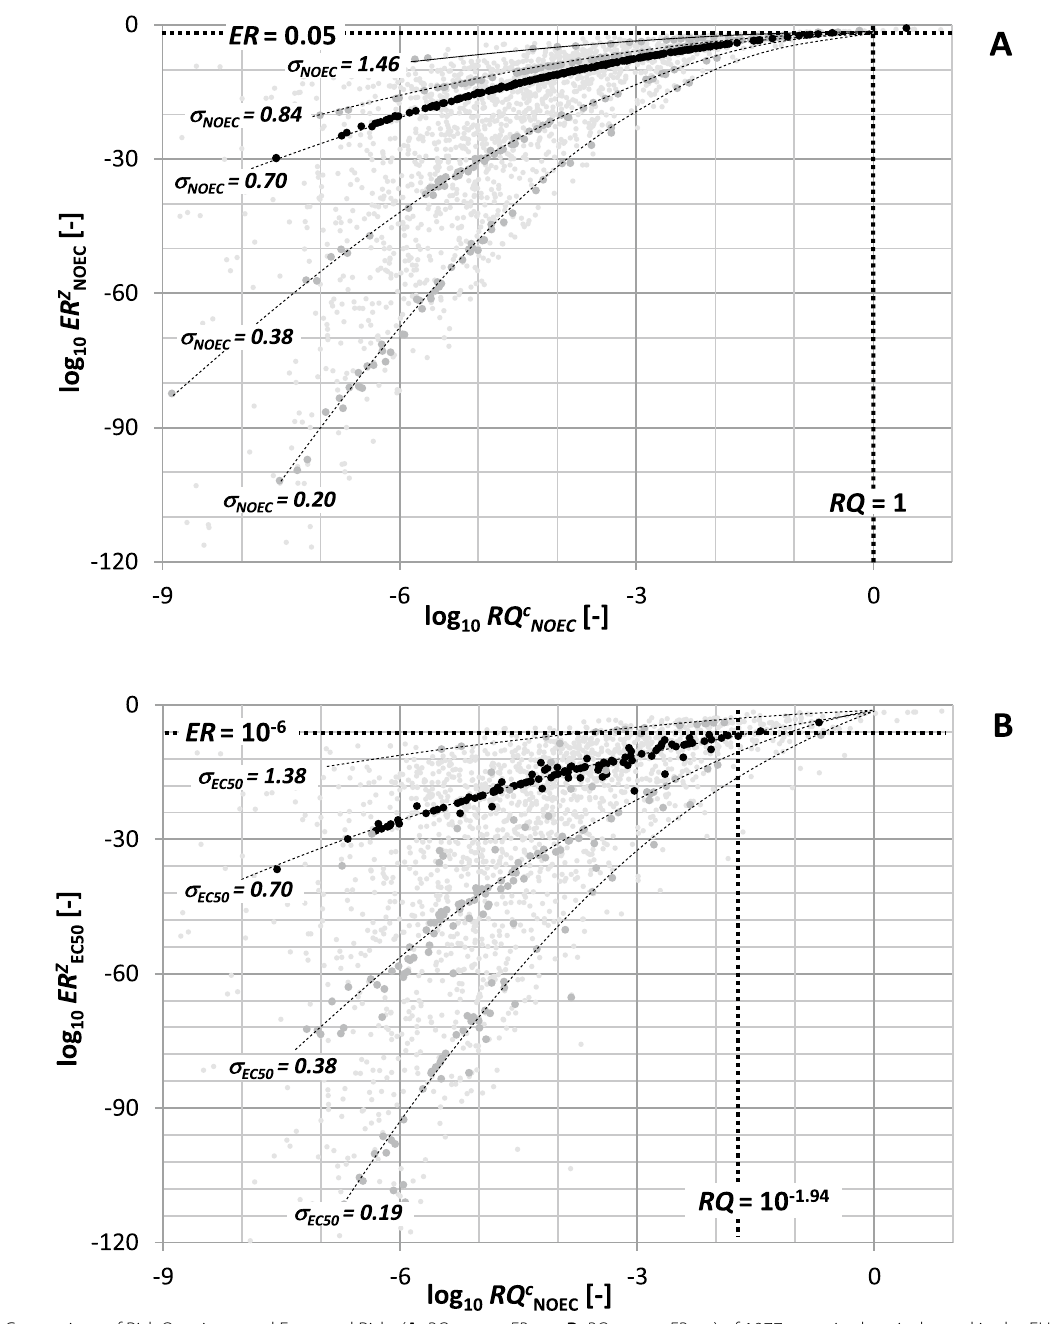
Fig. 7 Comparison of Risk Quotients and Expected Risks ( A : RQ NOEC vs. ER NOEC ; B : RQ NOEC vs. ER EC50 ) of 1977 organic chemicals used in the EU. Each dot indicates one chemical. Curved lines represent quadratic regressions through substances of equal interspecies variance ( σ NOEC , σ EC50 ) as published by Posthuma et al.